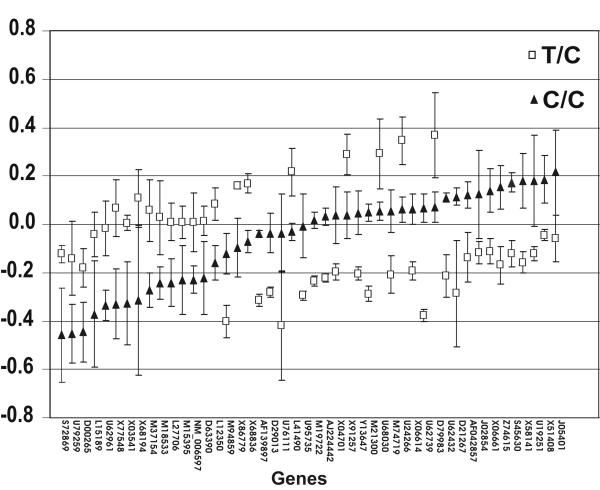
The control correction method identifies gene expression changes from spots with variable C/C ratios. The log ratios for each gene are plotted both for the T/C (□) and the corresponding C/C (▲) hybridizations for the 46 genes selected from control correction method. The error bars represent one standard deviation in each direction.